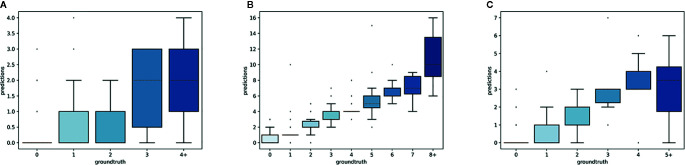
Box-plots of the predicted vs. expected counts for each type of reproductive structure. From left to right: (A) buds, (B) flowers, (C) fruits.